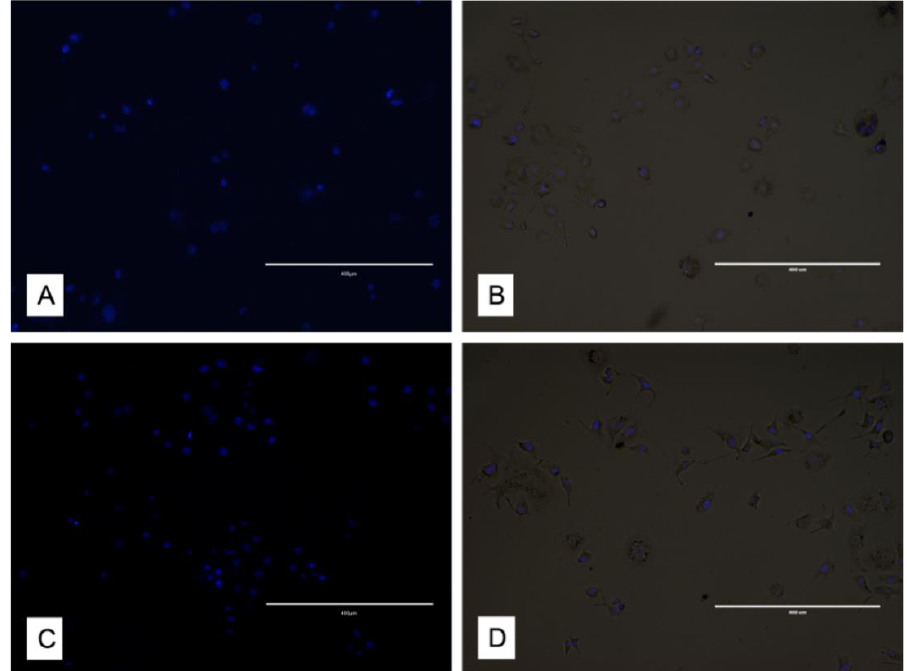
Figure 6. DAPI analysis highlights the nuclei of cells from the samples: ( A , B ) culture in presence of zirconium at 24 h; ( C , D ) culture in presence of titanium at 24 h. The figures on the left ( A – C ) were obtained through blue light, while those on the left ( B – D ) were through white light. Scale bar 400 μm.